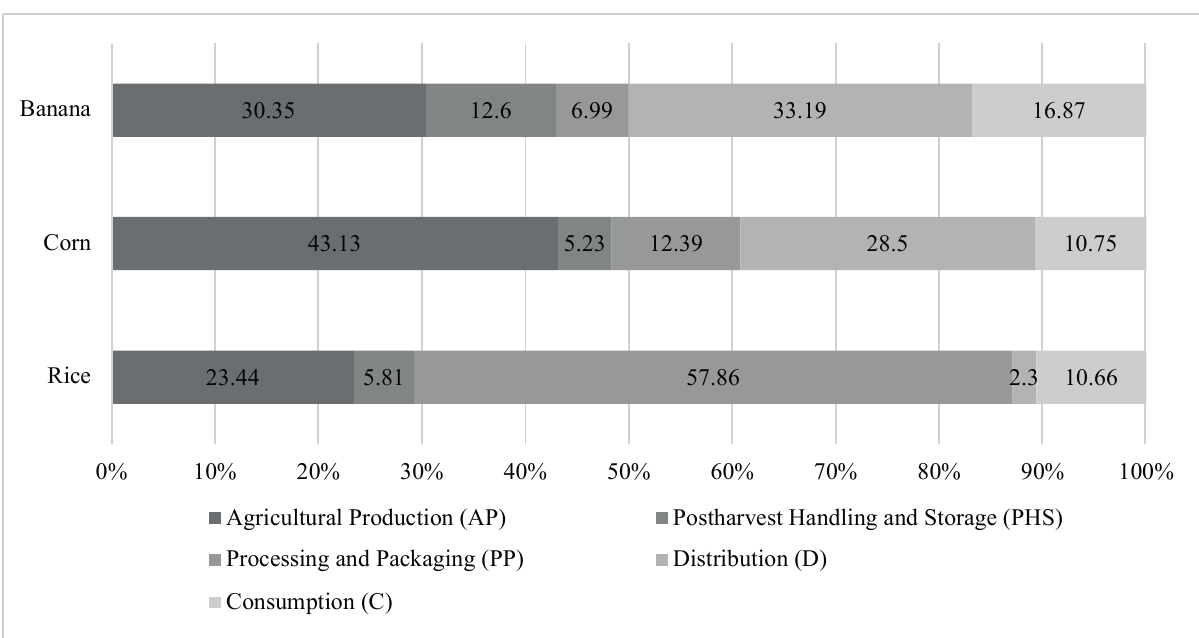
Figure 2. Total estimated FLW shares in each FSC stage by commodity. Source: authors’